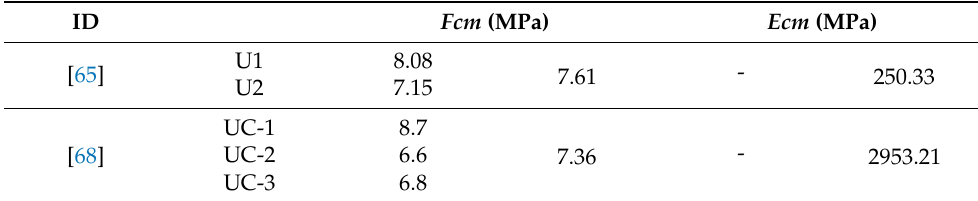
Figure 6. Geometrical details of stress–strain relationship: ( a ) Cascardi et al. [65] and Sneed at al. [68]. The columns were tested under axial compression, and the typical failure observed was masonry crashing (brittle failure) through a vertical crack in the mortar joints that was then propagated at the single clay brick units. In Table 2, a compressive strength f cm (peak stress) and the elastic modulus in compression E cm were reported. The value of E ct (elastic modulus in tension) was set equal to compression. Table 2. Test result of unreinforced